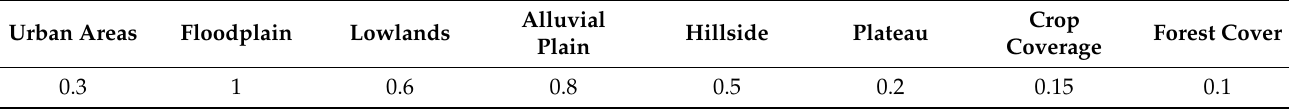
Table 9. Estimation of parameter, φ for the Babolroud watershed.